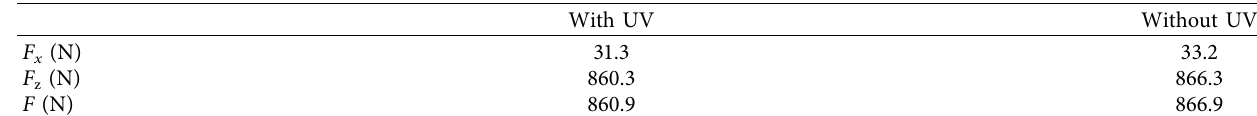
Figure 6: Deformed straight grooves obtained from FE simulation. Table 1: Average values of forming forces.